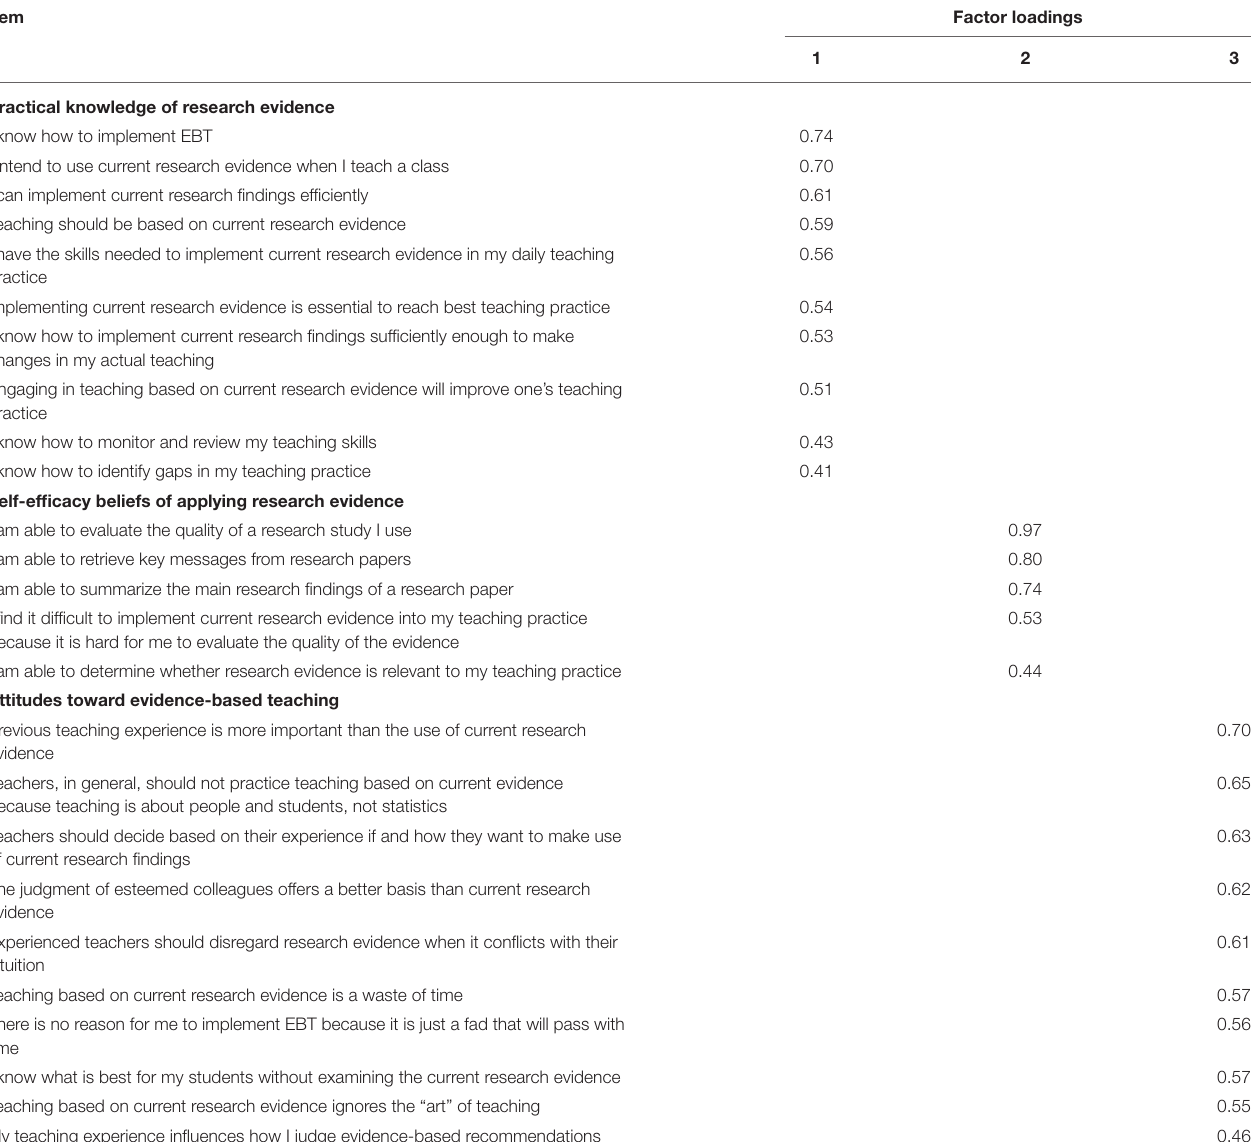
TABLE 2 | The evidence-based teaching scale: item factor loadings.